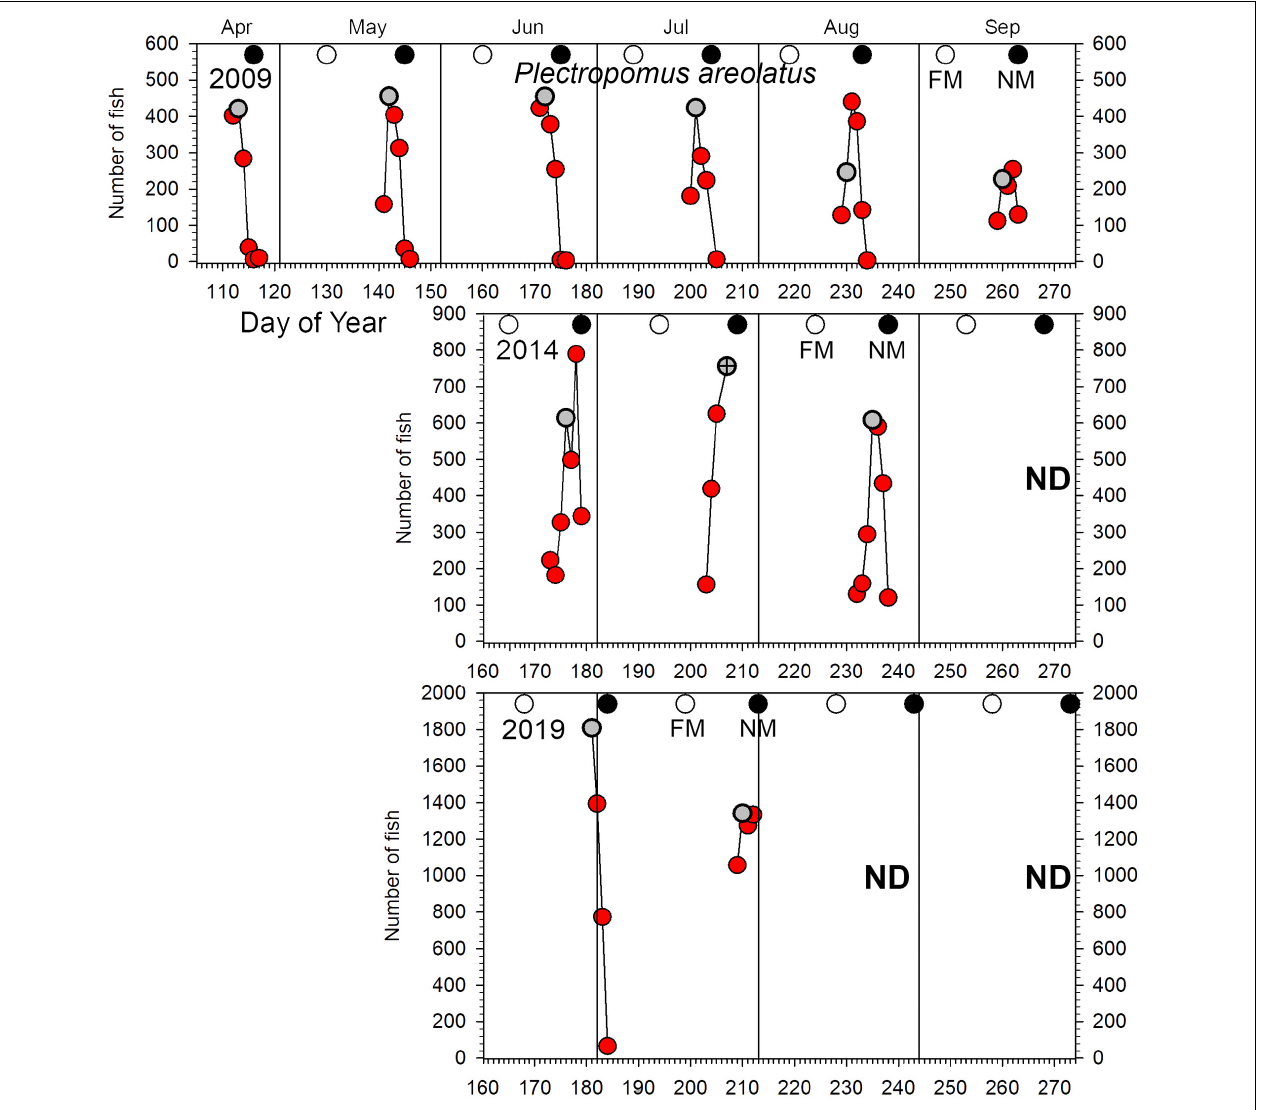
FIGURE 3 | Number of P. areolatus counted in UVC surveys across the Ebiil site in 2009, 2014, and 2019 for the major aggregation period by day of the year and relative to full and new moon phases. The gray circles indicate day 3 before new moon (3 BNM), except for July 2014 when poor weather cut short surveys; for this month the symbol has a cross in its center and indicates 2 days BNM. Note differences in y -axes across years. ND, no